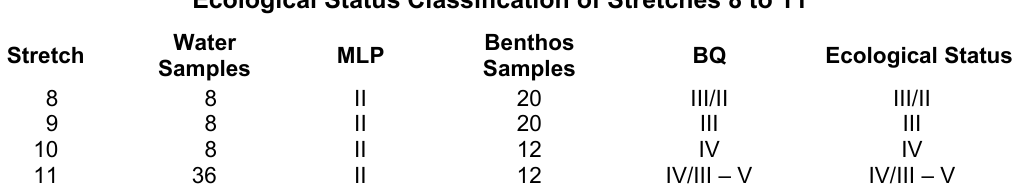
Ecological Status Classification of Stretches 8 to